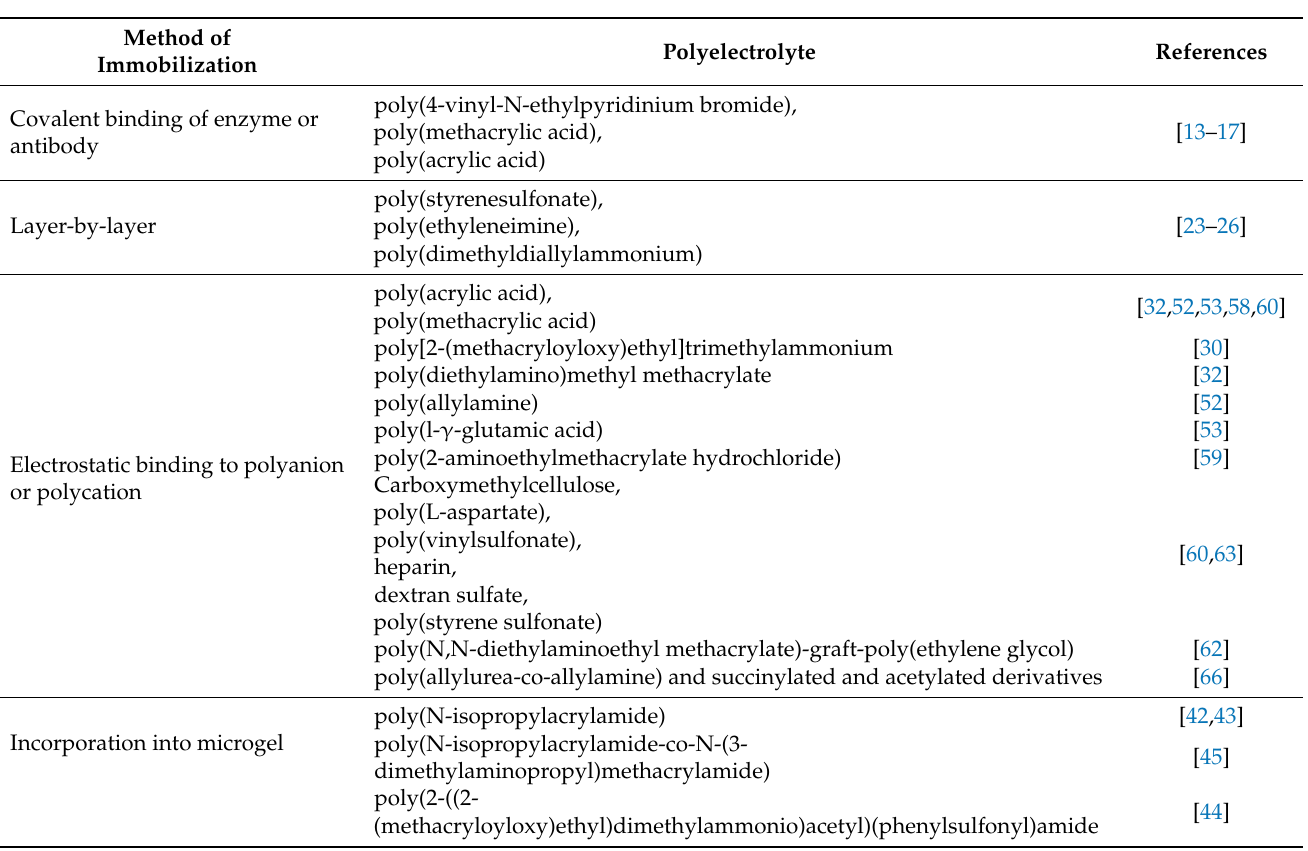
Table 1. Examples of different immobilization